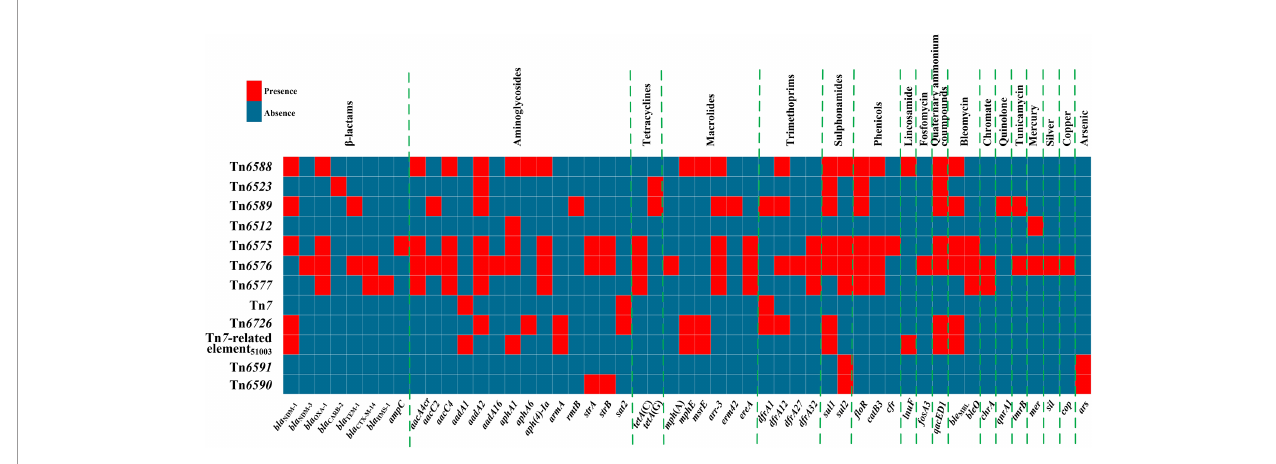
FIGURE 1 | A heatmap of prevalence of resistance genes. The original data are shown in Table S2